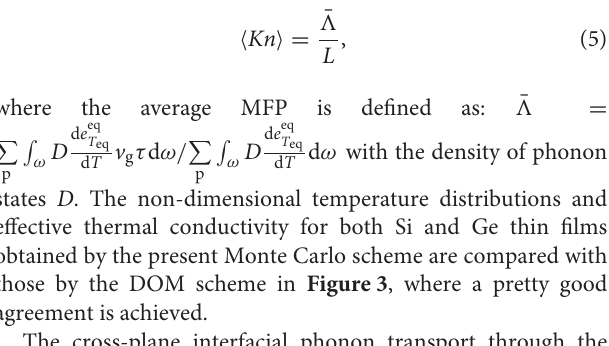
( T l ) and right side ( T r ) change to 301 and 299 K, respectively.